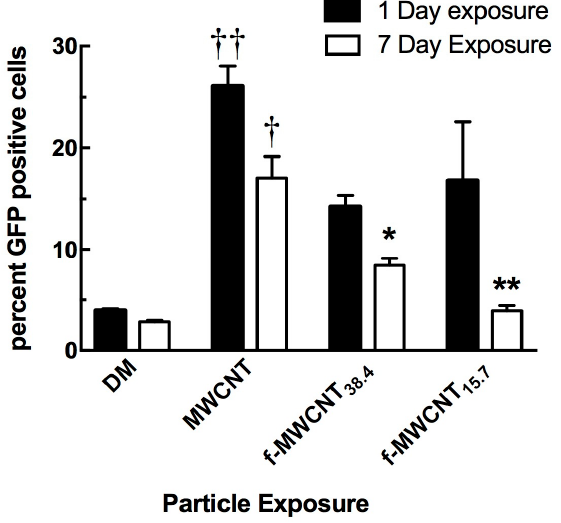
Figure 4. MWCNT functionalization effects autophagy as seen by GFP LC3 detection following particle instillation. One-day particle instillation of 50 μ g indicated by dark bars. The seven-day instillation of 50 μ g indicated by white bars. Data are expressed as mean ± SEM percent macrophages expressing LC3 green fluorescent protein, which indicates the presence of autophagic activity. Functionalization of 38.4 is 5 min of processing and 15.7 is 60 min of processing. Daggers †† indicate significance at p < 0.01, or † indicating significance at p < 0.05 compared to corresponding DM vehicle negative controls. Asterisks ** indicate significance at p < 0.01, or * indicating significance at p < 0.05 compared to corresponding MWCNT source controls. n = 3–4 mice per group.